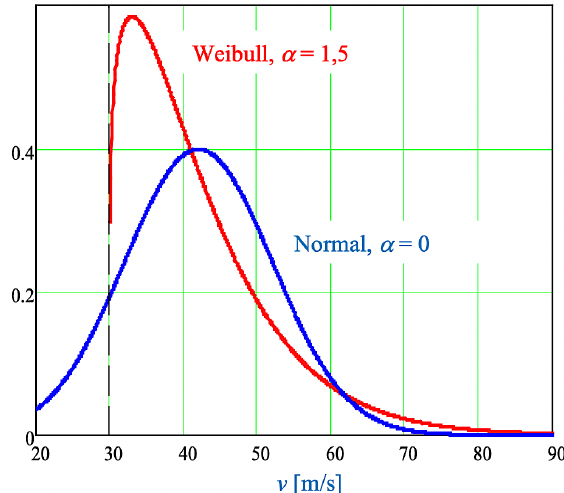
Figure 2. Distributions of tornado wind speed for N = 1 and